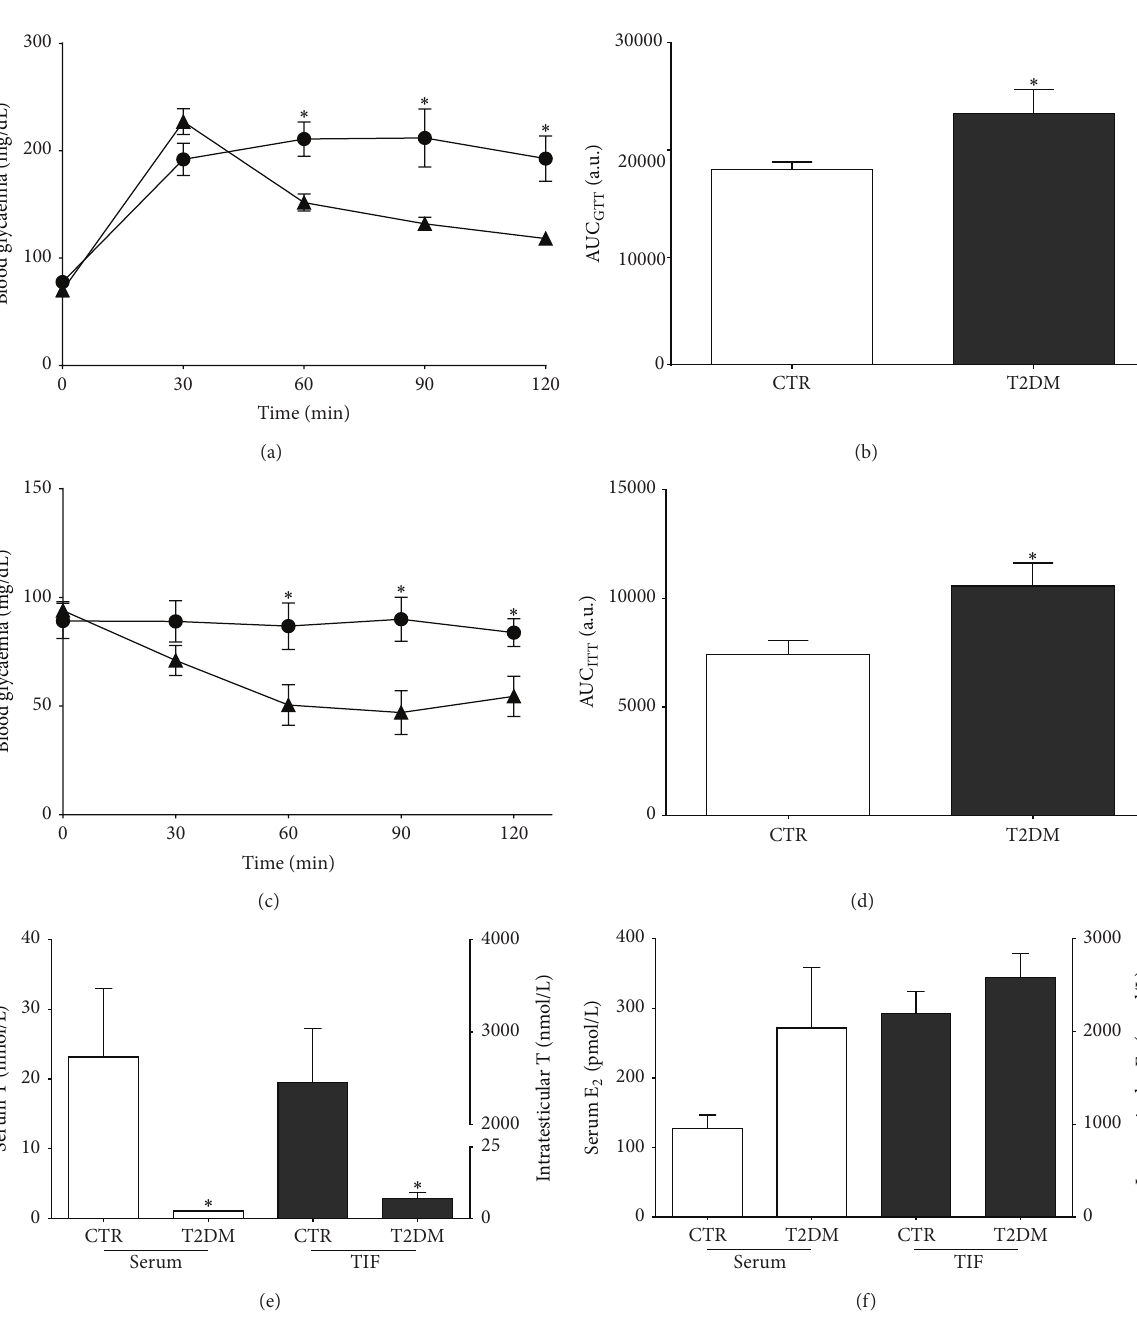
Figure 1: Type 2 diabetes mellitus (T2DM) induces (a and b) glucose intolerance and (c and d) insulin resistance and significantly alters both (e) serum and testicular testosterone levels. (a) Blood glucose levels of the control group ( 󳵳 ) and T2DM group ( e ) measured during intraperitoneal glucose tolerance test. (b) Area under the curve for the intraperitoneal glucose tolerance test (AUC GTT ) performed in control and T2DM group rats. (c) Blood glucose levels of the control group ( 󳵳 ) and T2DM group ( e ) measured during intraperitoneal insulin tolerance test. (d) Area under the curve for the intraperitoneal insulin tolerance test (AUC ITT ) performed in control and T2DM group rats. (e) Testosterone levels in intratesticular interstitial fluid and serum of control and T2DM group rats. (f) 17 𝛽 -Estradiol levels in intratesticular interstitial fluid and serum of control and T2DM group rats. Results are presented as mean ± SEM of six independent experiments, corresponding to six animals/group. *Significantly different relative to control ( 𝑃 < 0.05